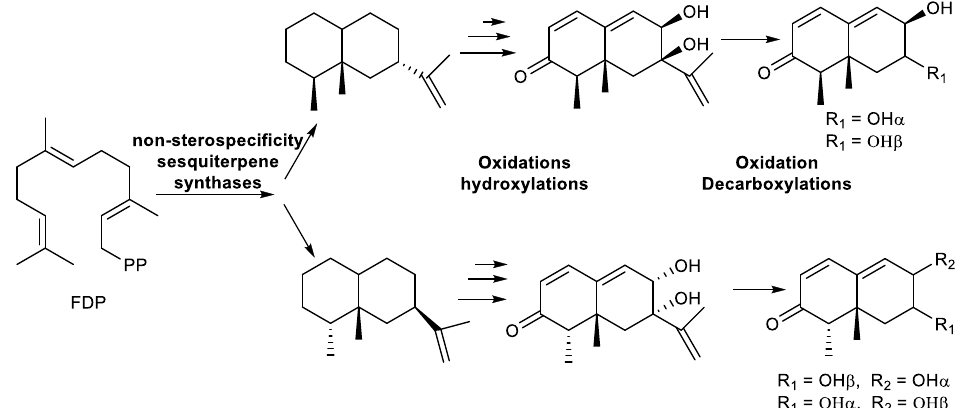
Figure 15. Proposed biosynthetic pathway to tri- nor -eremophilanes (adapted from Liu et al. 2016